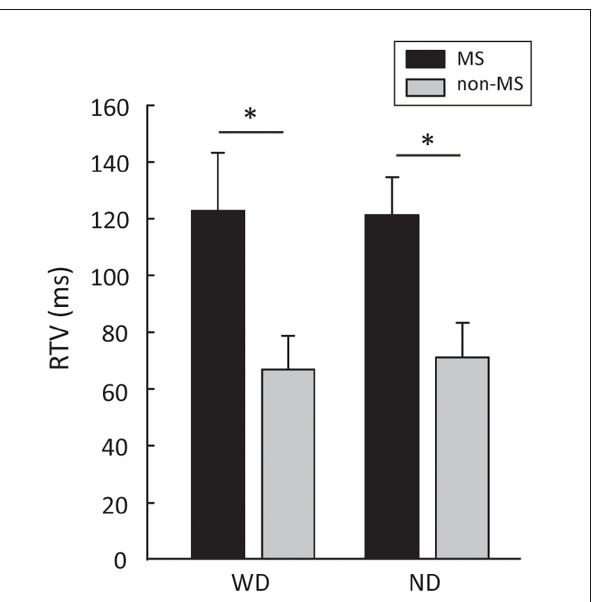
FIGURE2 GroupdifferencesbetweenpeoplewithMSandnon-MSparticipants in RTV. Error bars represent SEM. MS, multiple sclerosis; RTV, response time variability; WD, with distractors; ND, no distractors. ∗ p <